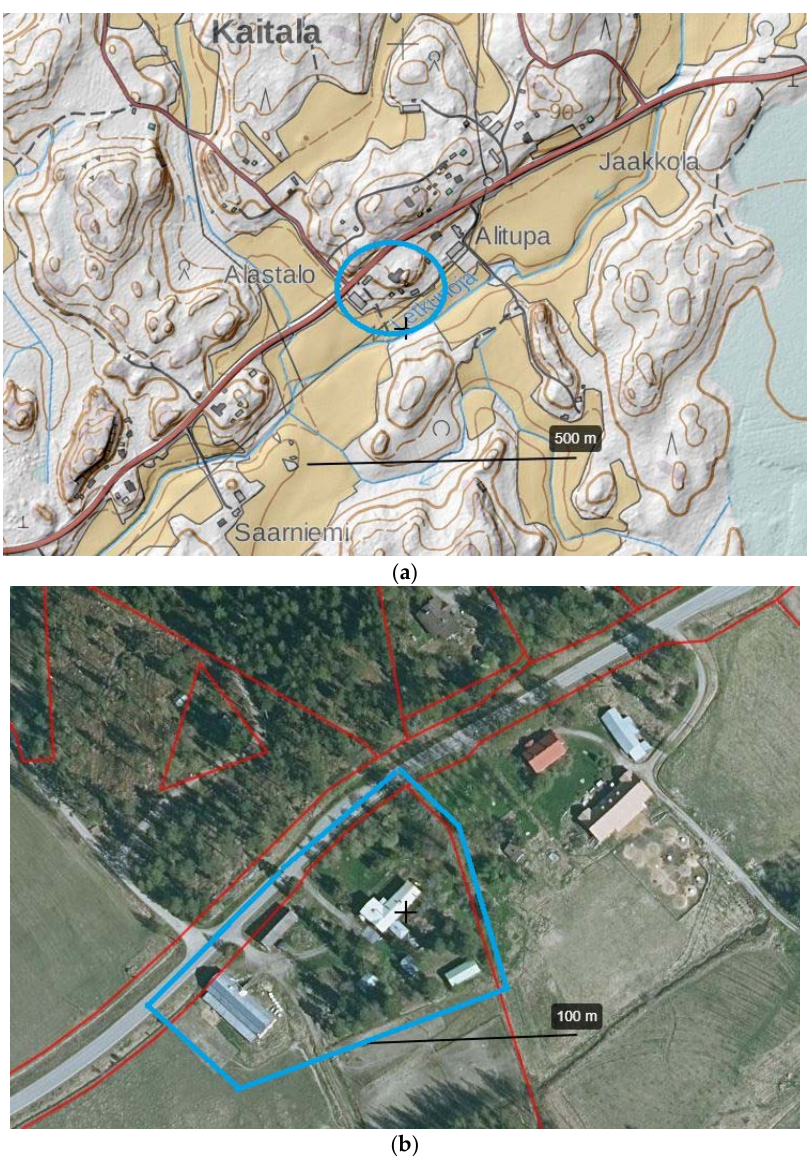
Figure 2. ( a ) The case study farm location in the village [20]. ( b ) Location of the case study buildings at the site [20].